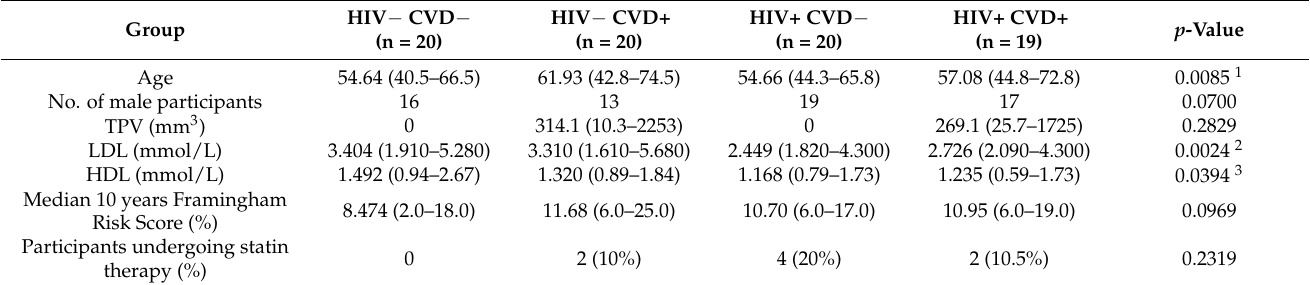
Table 1. Sociodemographic characteristics of the sub-cohort (A) used in this